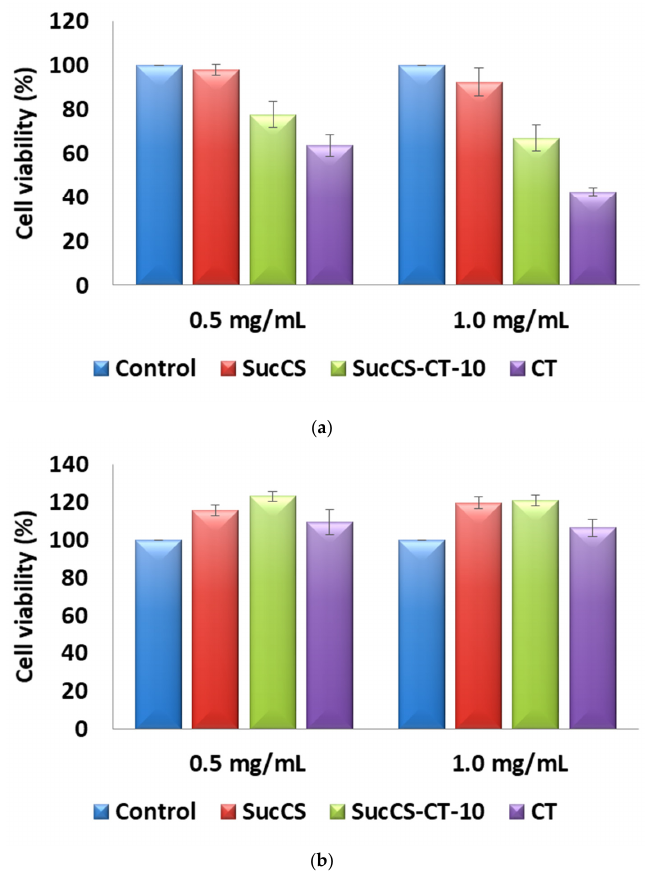
Figure 7. Viability of HEK 293 ( a ) and T 98G ( b ) cells incubated in the presence of SucCS-CT-10, SucCS, and native CT for 72 h. The CT concentrations in the tested samples were 0.5 and 1.0 mg/mL. Data are presented as mean ± SD ( n = 5).